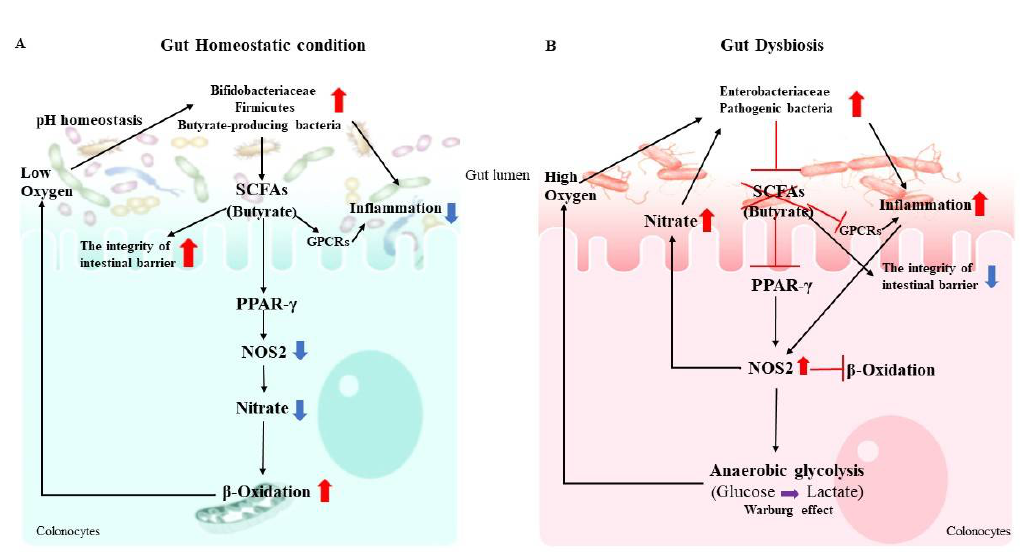
Figure 1. The interaction between microbiota-derived metabolism in the gut epithelium. ( A ) In the gut homeostatic condition, gut microbiota, especially butyrate-producing bacteria, metabolizes fiber into fermentation products such as short chain fatty acids (SCFAs). These SCFAs stimulate a PPAR- γ –dependent stimulation of mitochondrial-oxidation, consequently decreasing epithelial oxygenation. SCFAs also directly bind to epithelial and immune cell G protein-coupled receptors (GPCRs) that reduce gut inflammation, such as GPR41, GPR43, and GPR109A. ( B ) During gut dysbiosis, Enterobacteriaceae use virulence factors to stimulate neutrophil migration through the epithelium, reducing SCFA-producing bacteria, decreasing the abundance of short-chain fatty acids in the lumen. The subsequent metabolic shifts of the epithelial layer increases available oxygen (O 2 ) and lactate in the lumen. Arrows represent increases (red) and decreases (blue) in bacterial abundances, metabolites, and downstream e ff ects observed in the homeostatic and dysbiotic guts. Host-body defense systems use multiple mechanisms to discourage colonization by pathogens.